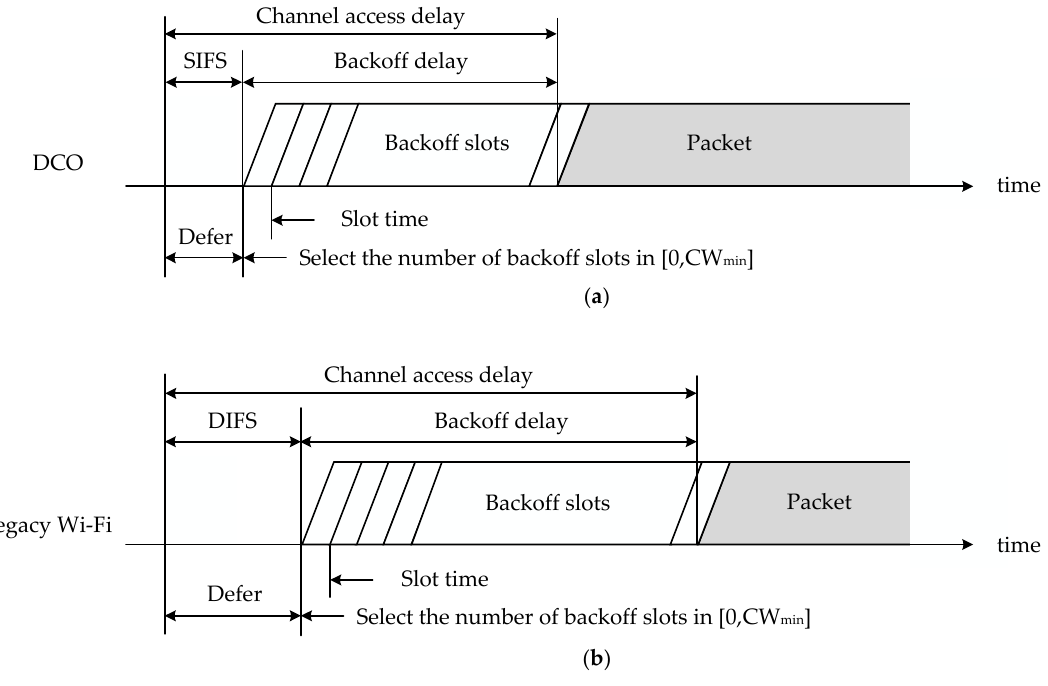
Figure 2. Comparison of initial channel access: ( a ) DCO; and ( b ) legacy Wi ‐ Fi.